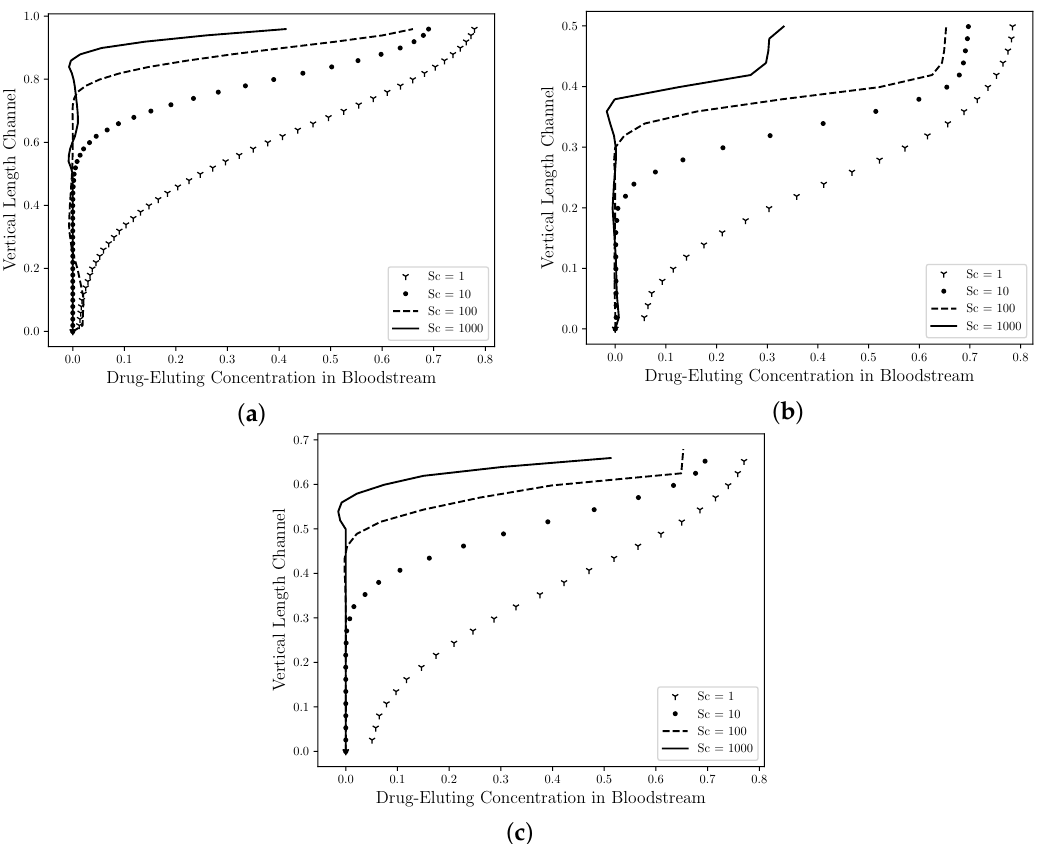
Figure 10. The state steady of the drug diffusion profiles in the middle ( x = 5.0 R) for the straight channel ( a ), the curved channel ( b ) and the real channel ( c ) with drug-eluting stent. The concentration values are presented by nondimensional values. It is observed that the maximum concentration field is decreased as the Schmidt number increases. In addition, the chemical species transport is dislocated in an upward direction and it becomes in a fine jet close to the drug-eluting stent. Therefore, it is estimated that the concentration field has a similar profile to all cases and neither the atherosclerosis nor the model channel influenced the dynamics of the drug